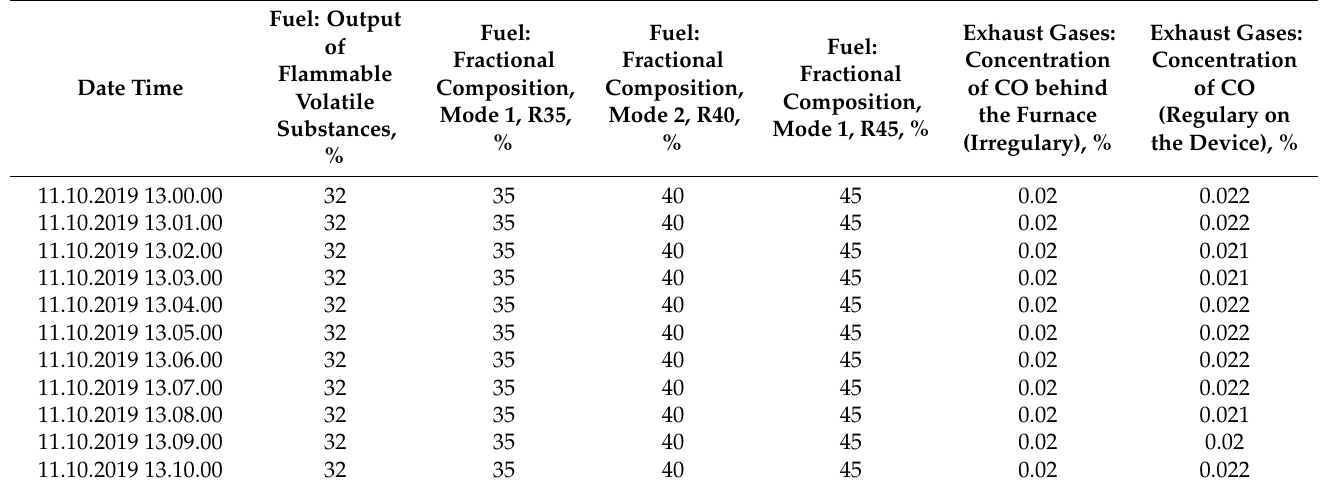
Table 2. Database appearance (Part 2).